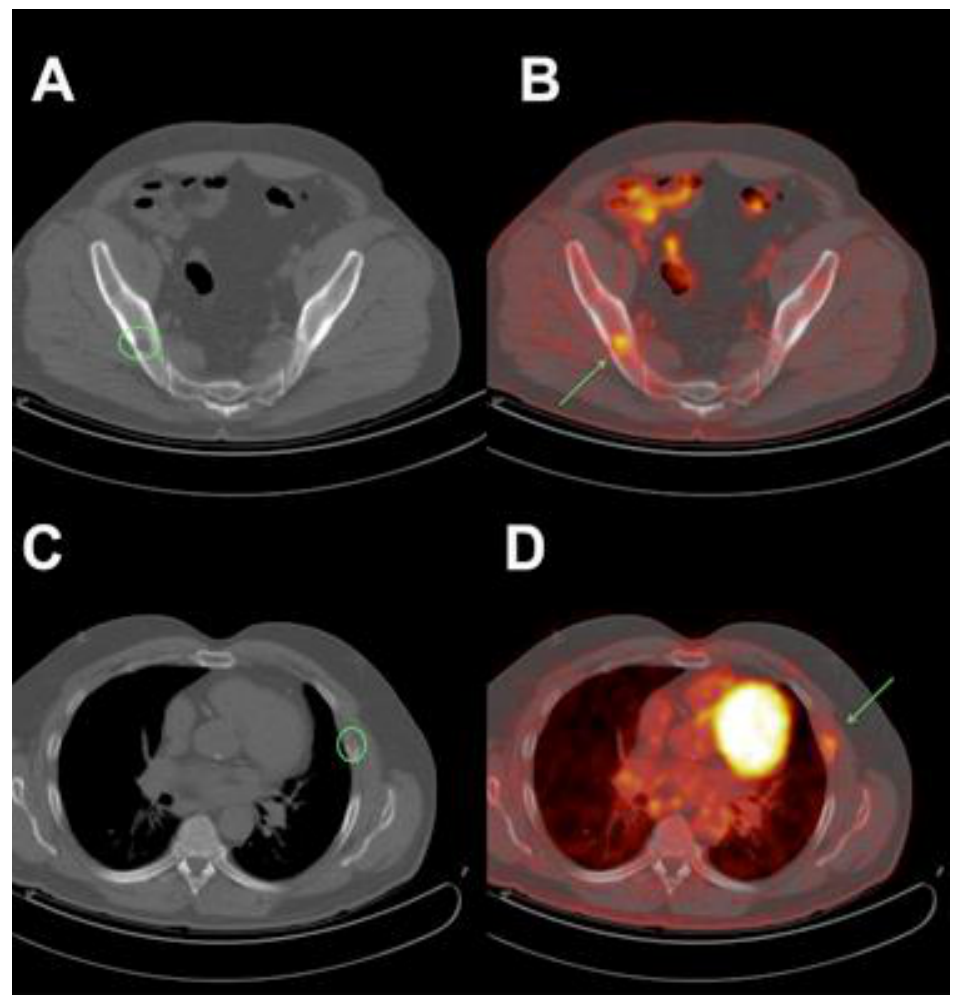
Figure 6. Panel of 18 F-FDG PET-CT imaging at 6 months follow-up of patient 7. There are 2 FDG-avid bone localizations strongly suspected of being metastases ( A, B ). The low-dose CT scan without contrast shows cystic lesions in the right iliac bone ( A , green circle) and in the fifth left costal rib ( C , green circle). Both cystic locations correlated with the “hot spot” FDG uptake as shown in B and D (green